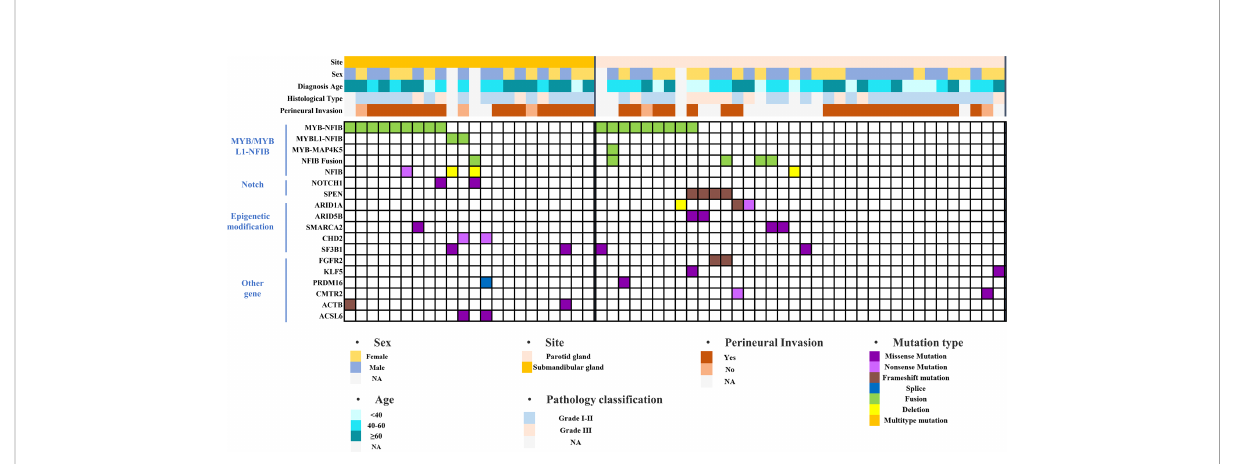
FIGURE 6 Mutation landscape of submandibular gland and parotid gland ACC based on the cBioPortal